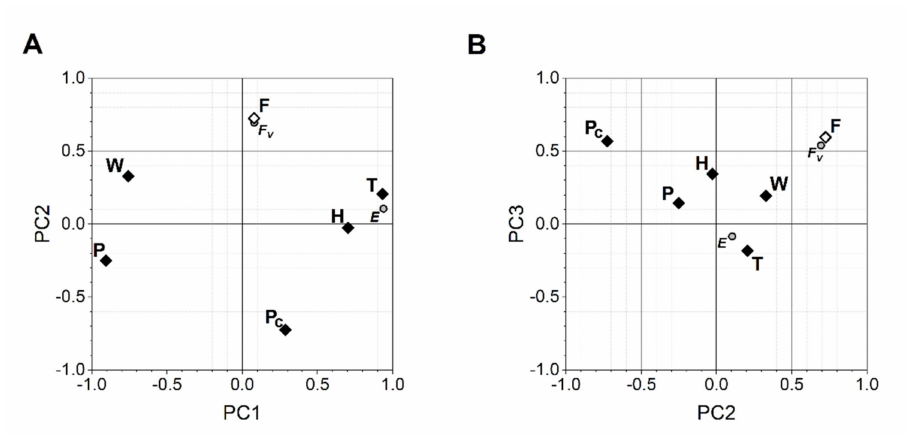
Figure 2. Projection of the temperature (T), humidity (H), wind speed (W), air pressure (P), air pressure change (Pc) and fertility (F) variables on ( A ) PC1 vs. PC2 and ( B ) PC2 vs. PC3 planes. The meteorological variables are marked as open diamonds, the fertility variable—as dark diamonds. Within-day fertility variance (Fv) and experiment (E) supplementary variables are marked as grey circles. Supplementary variables were not used in PCA to determine PCs. Each PC axis represents the level of association between PCs and the variables